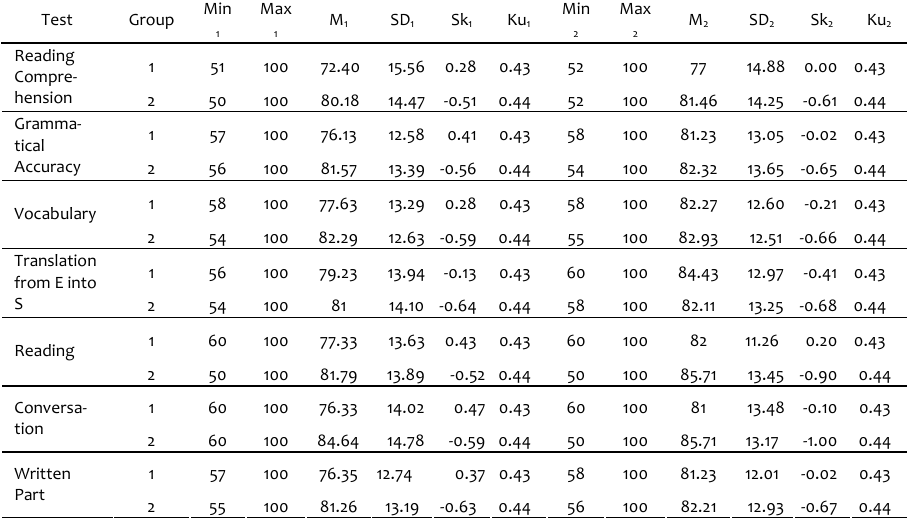
Table 1. Descriptive statistic for all tested variables before and after the ESP